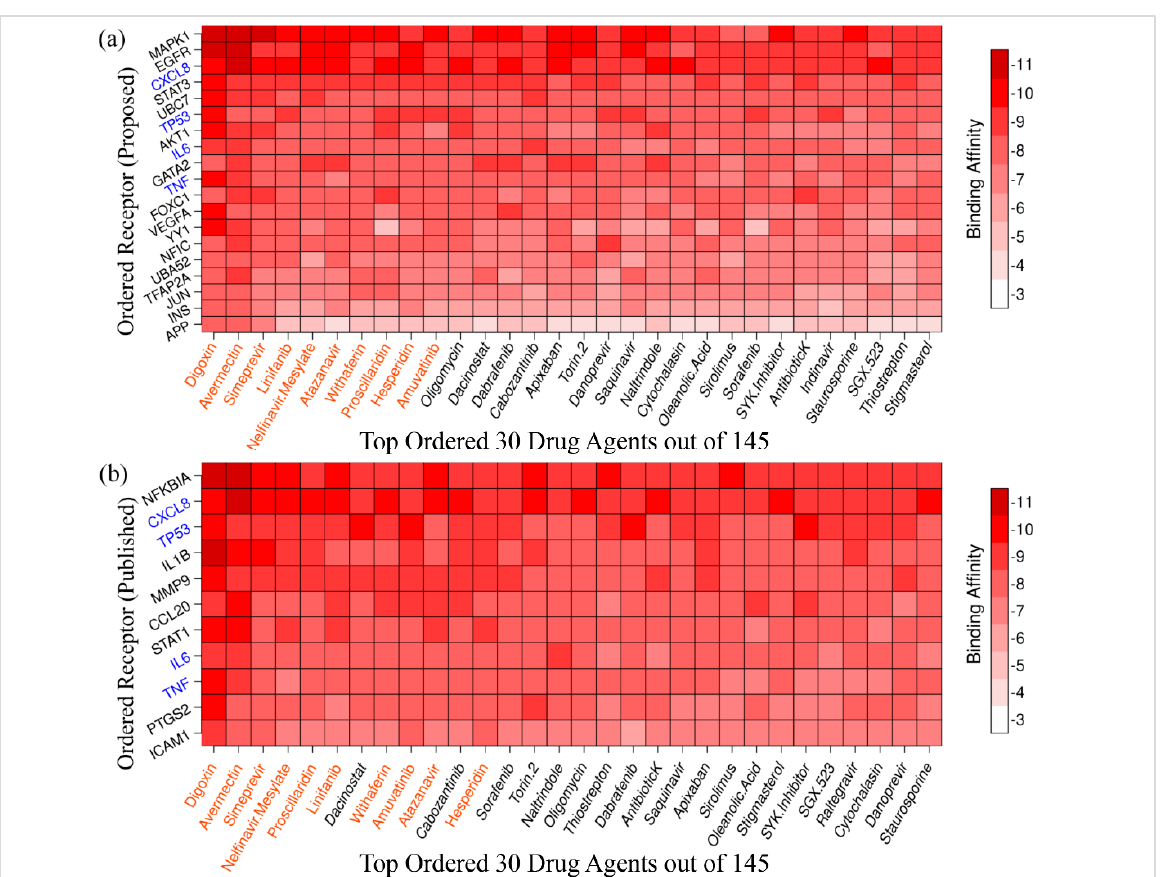
Figure 6. Binding affinity scores that were calculated by Autodock-vina. The color bar indicates the score levels, where deeper and lighter reds indicated the strong and weak binding, respectively. ( a ) The binding affinity scores based on the top-ranked 30 drug agents out of 145 on the X -axis and ordered 19 target proteins (proposed) on the Y -axis (Supplementary File S2). ( b ) The binding affinity scores that were based on the top-ranked 30 drug agents out of 145 on the X -axis and top-ranked 11 target proteins (previously published) on the Y -axis; see details in (Supplementary File S3). The receptors with blue color indicate the common receptors between the proposed and previously published top-ranked receptors.